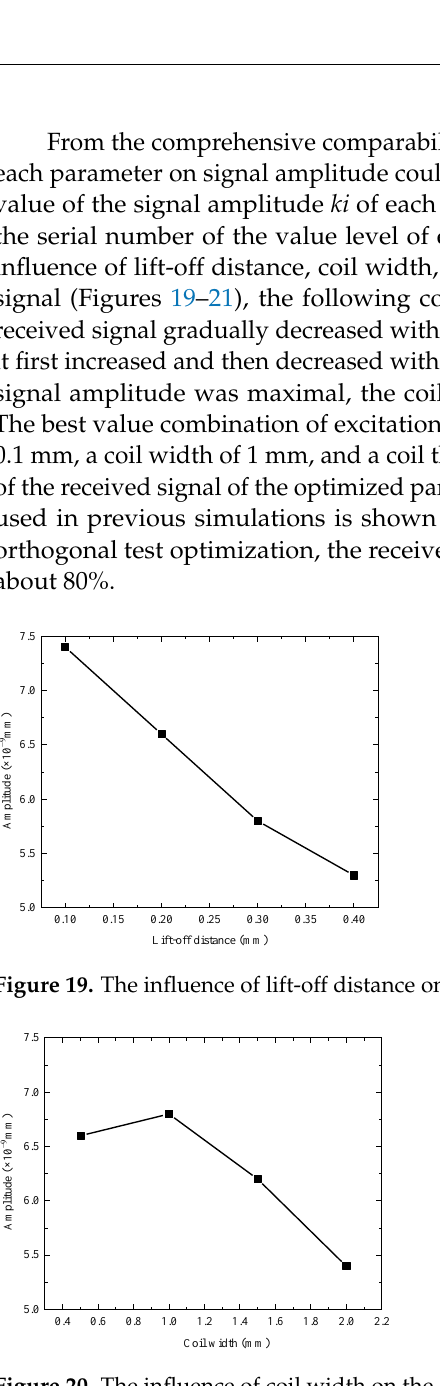
Figure 20. The influence of coil width on the amplitude of received signal.